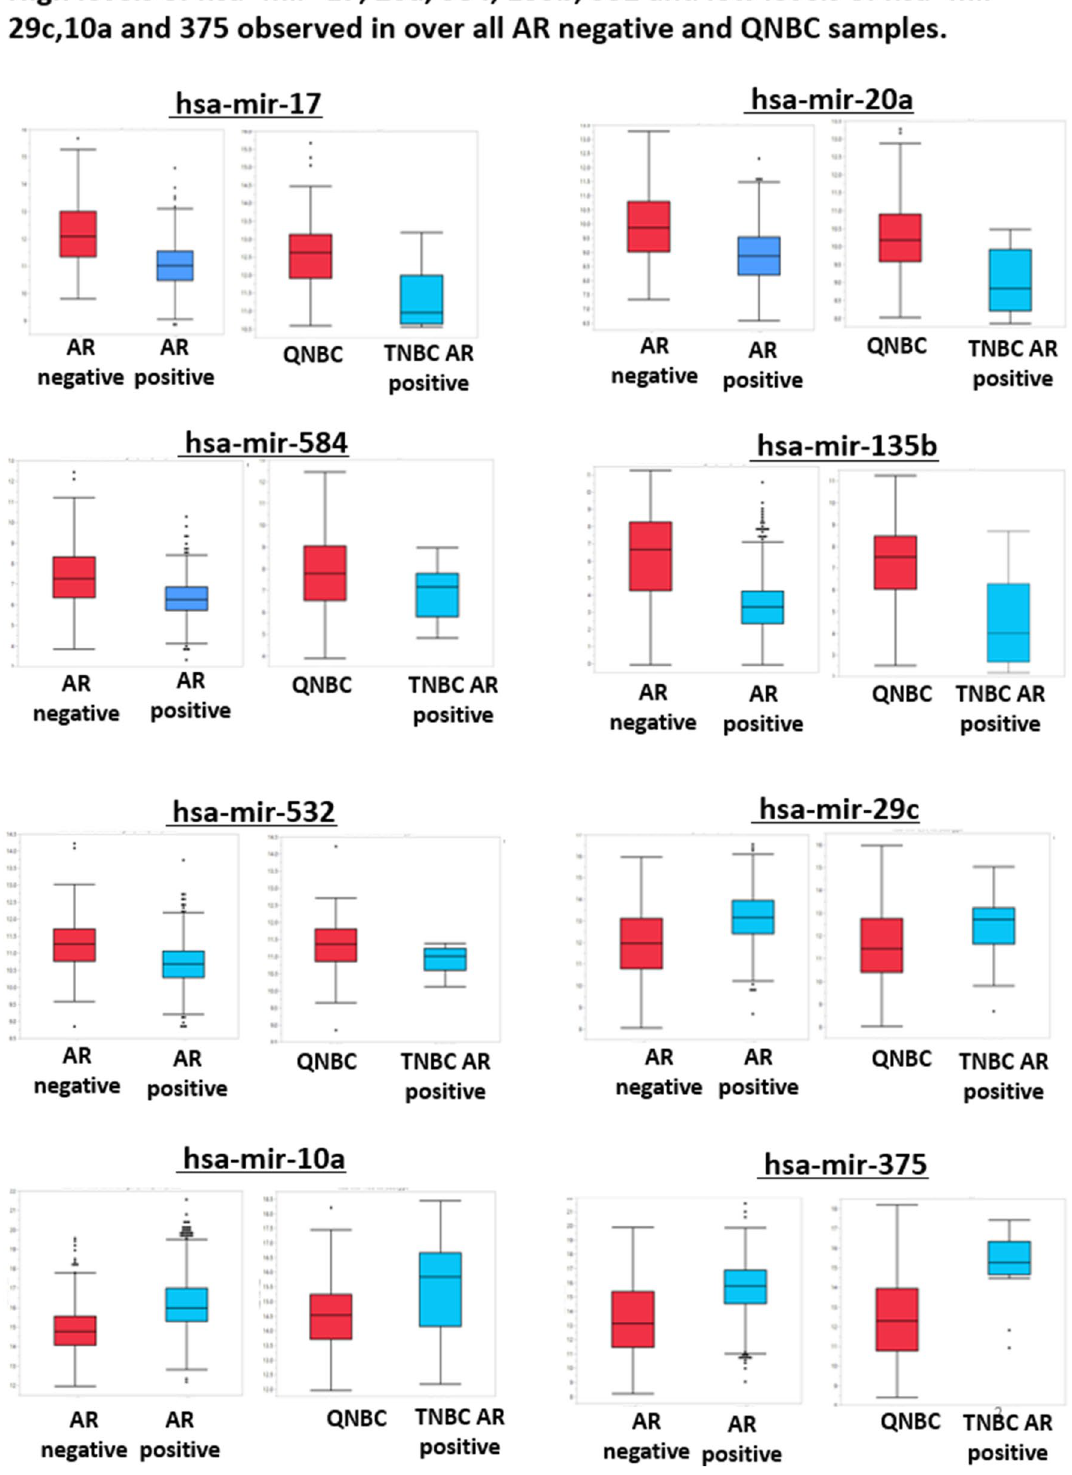
Figure 2. High levels of mir-17, mir-20a, mir-584, mir-135b, and mir-532 and low levels of mir-29c, mir-10a, and mir-375 are present in overall AR-negative breast cancers and QNBCs. Eight highly expressed miRNAs were selected; the box plot shows the expression of these miRNAs in AR-negative (n = 267) and AR-positive (n = 823) primary breast cancers (nonparametric Wilcoxon test p < 0.05). For AR-negative versus AR-positive overall the X-axis represents the AR status (negative or positive), and the Y-axis represents the miRNA expression normalized and log2 scale for the corresponding miRNA. For QNBC versus TNBC AR-positive, the box plot shows the expression of these miRNAs in QNBC primary breast cancers (n = 97) and AR-positive TNBC (n = 17) samples (non-parametric Wilcoxon test P < 0.05). The X-axis represents the subtype (QNBC or TNBC AR-positive), and the Y-axis represents the miRNA expression normalized and the log2 scale for the corresponding miRNA. There were high levels of mir-17, mir-20a, mir-584, mir-135b, and mir-532 and low levels of mir-29c, mir-10a, and mir-375 in overall AR-negative samples and